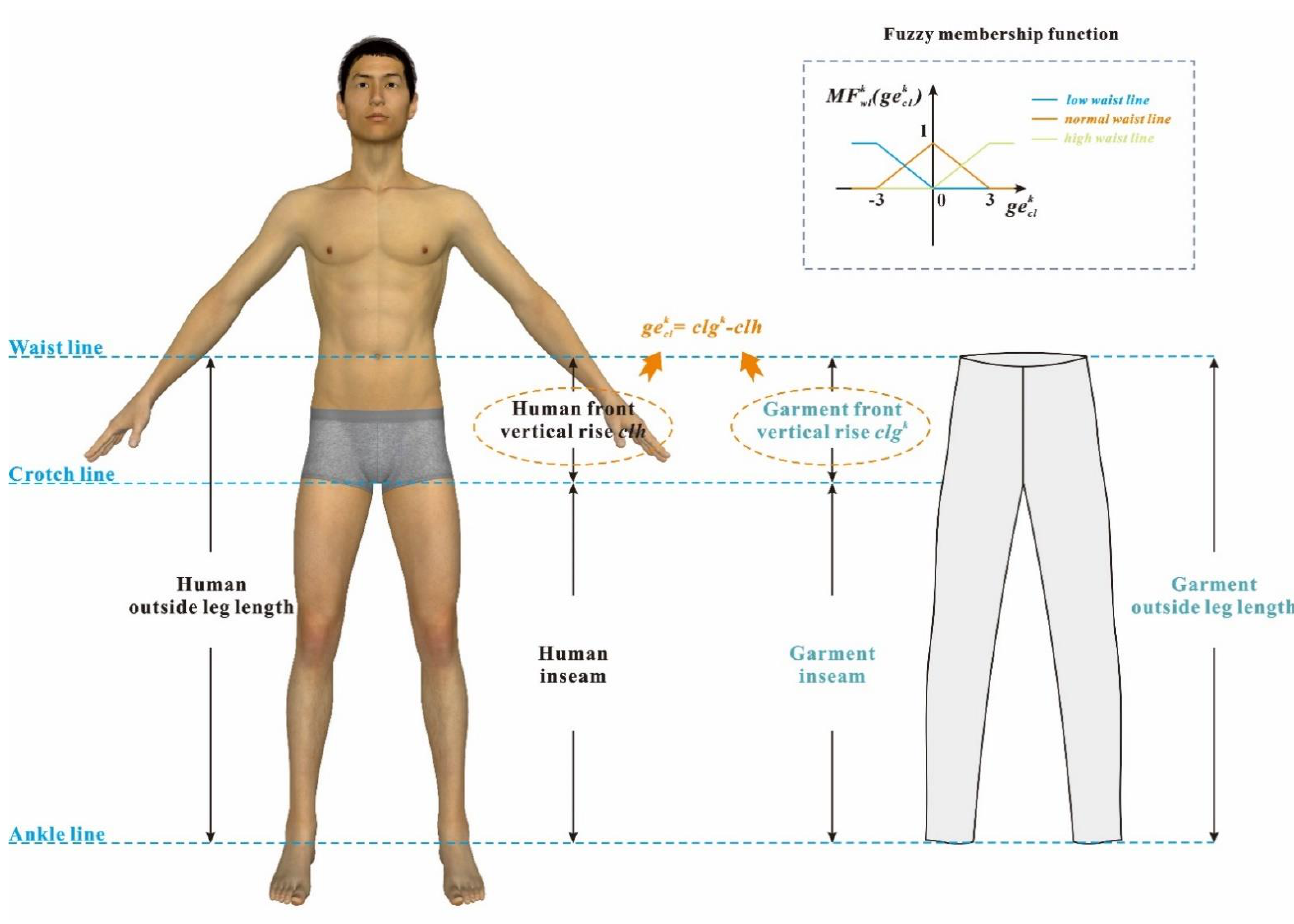
Figure 6. Fuzzy membership function of the waistline position. Table 3. The characteristics of the length and waistline position.